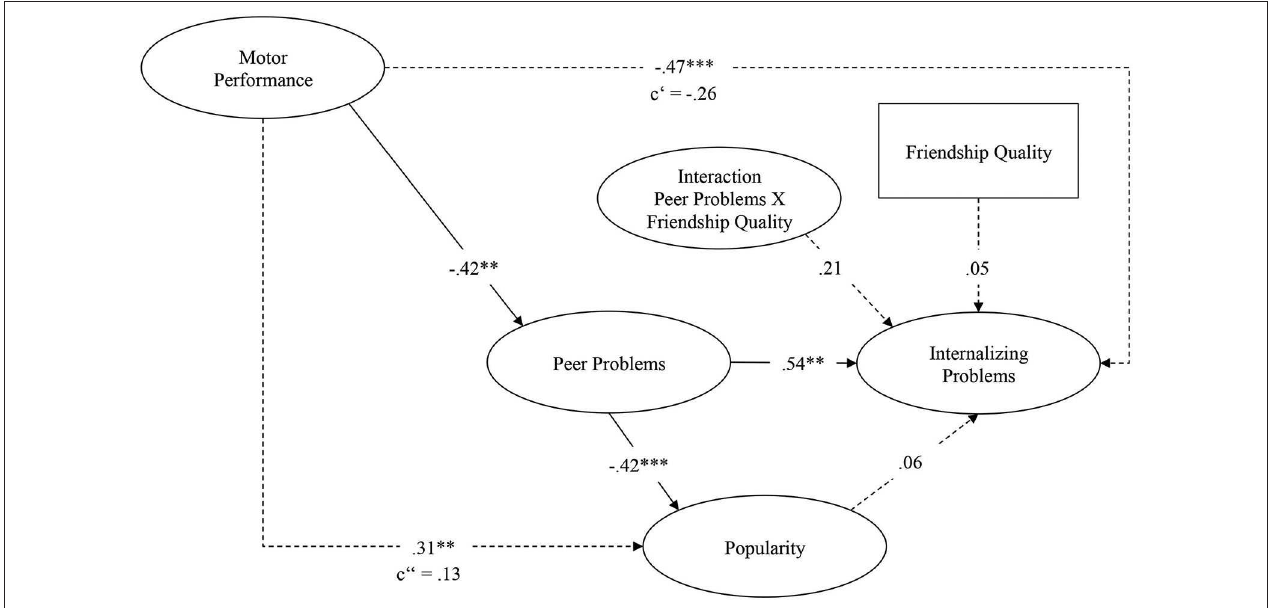
FIGURE 3 | Standardized results of the structural equation model. Model fit ( χ 2 = 160.52; df = 147; CFI = 0.97; RMSEA = 0.02; SRMR = 0.05). * p < 0.05; ** p < 0.01; *** p < 0.001.